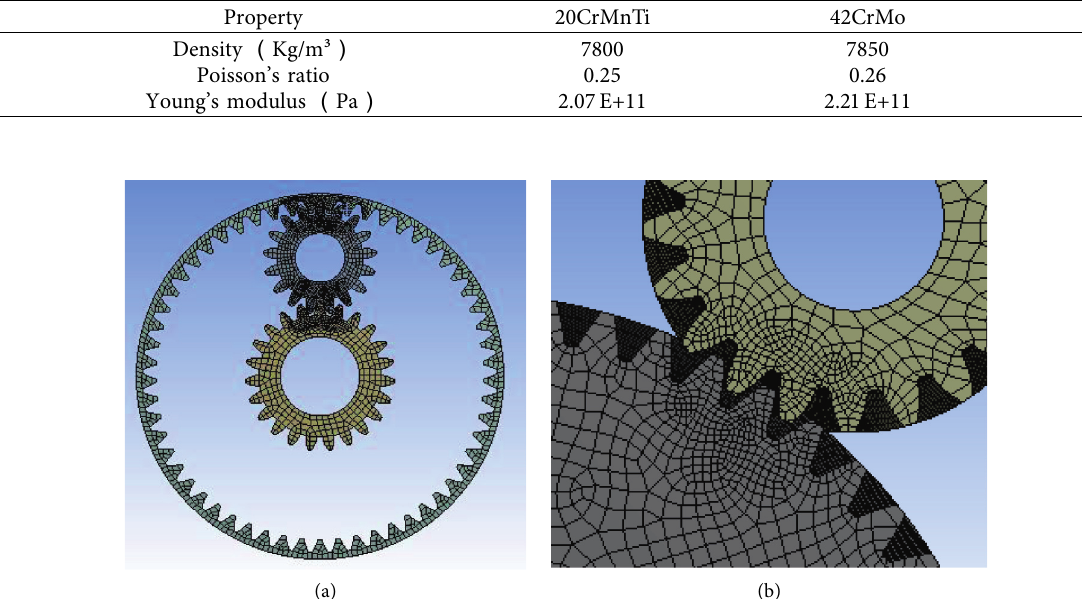
Figure 9: Finite element mesh of gears. (a) Planetary gear. (b) Helical